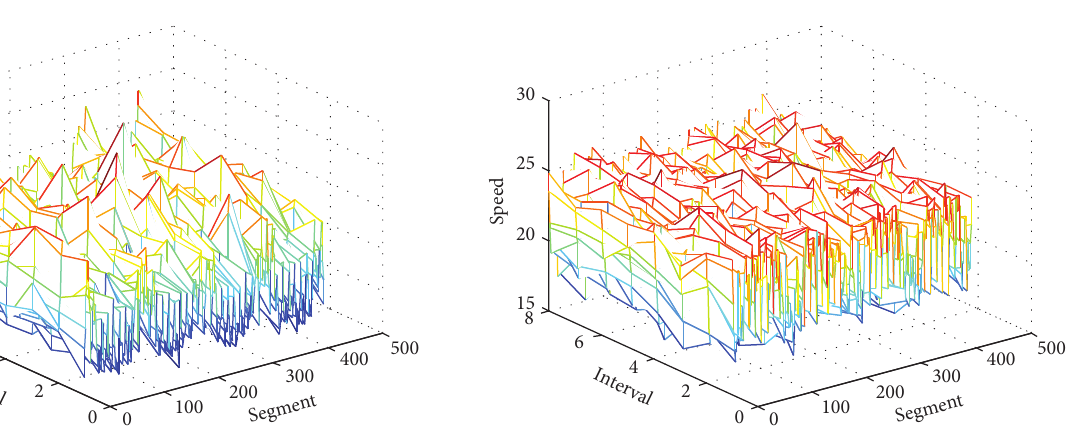
Figure 10: Speed on each segment per interval when demand is